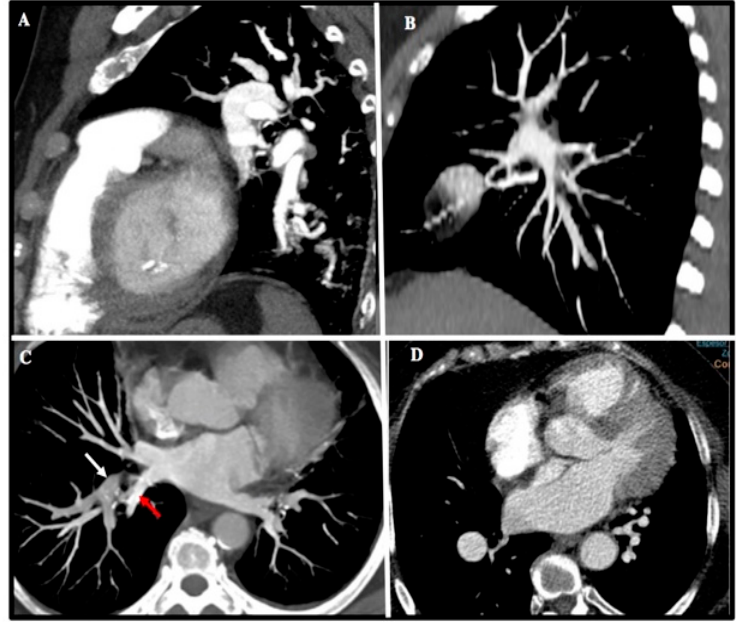
Figure 2. Common imagen artifacts found in MCTA. ( A ) Motion artifact at lower lobes. ( B ) CT stair artifact due to inadequate slice thickness. ( C ) Suboptimal contrast opacification of right upper lobe artery (white arrow) and inferior right vein (red arrow). ( D ) CT image noise in an obese patient.